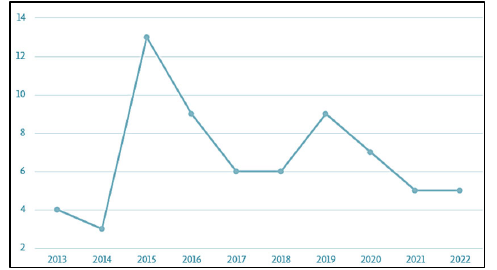
Fig. 4. Countries that published according to the relationships of the word "Artificial Leaf". Source: Scopus scientific